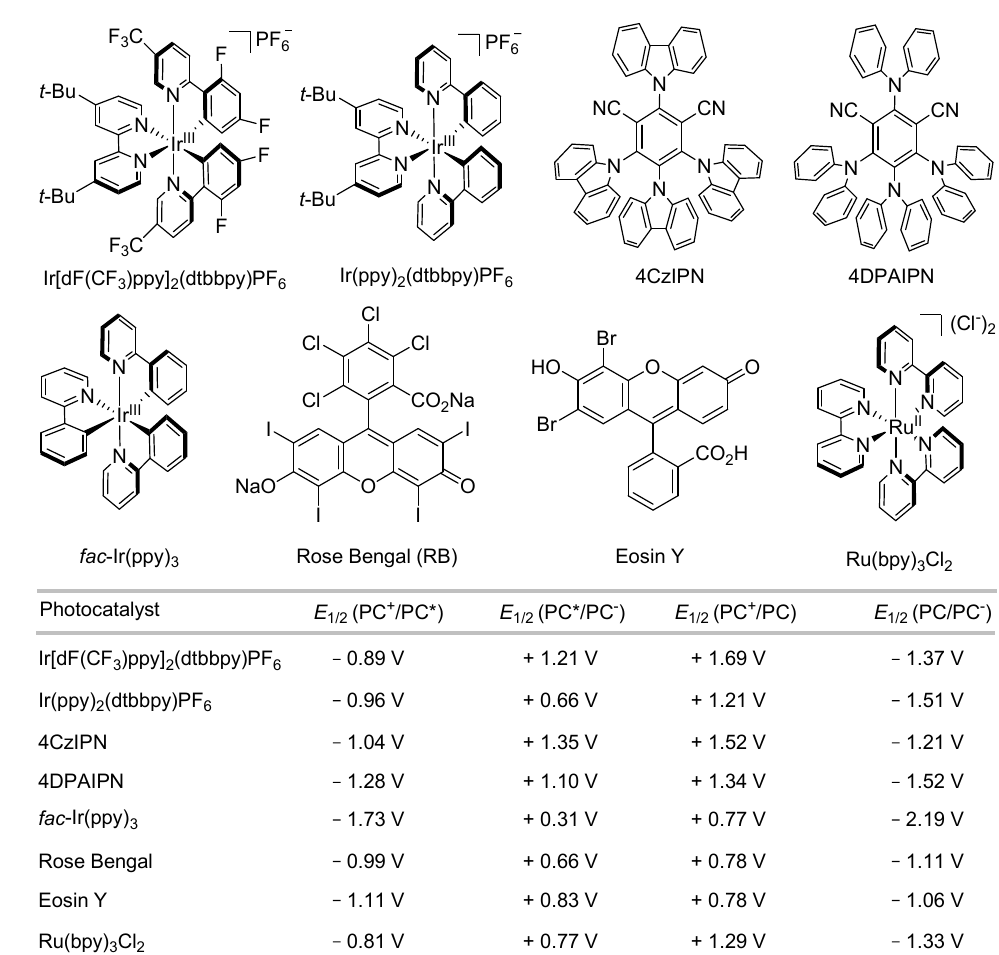
Scheme 2. Typical photocatalysts for C-F bond cleavage and their redox potentials.